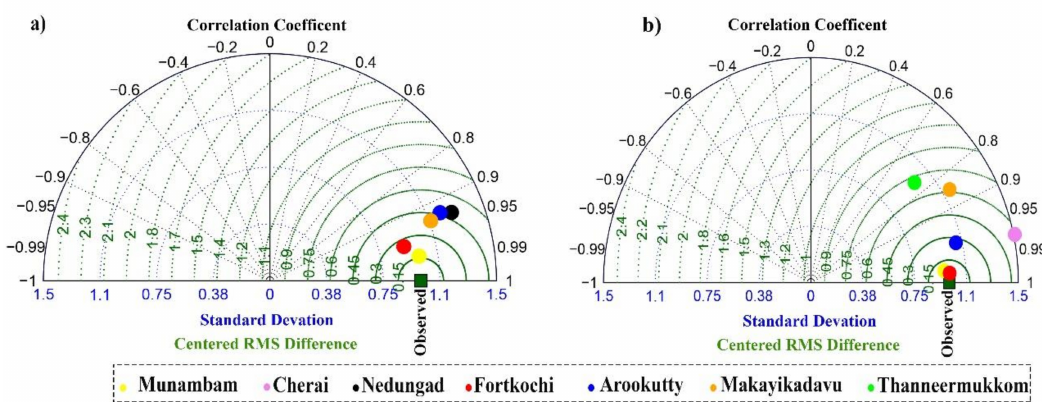
Figure 5. Normalized Taylor diagram for the statistical significance of the surface water elevation of the model during the ( a ) pre-monsoon (2010) and ( b ) monsoon (2010).